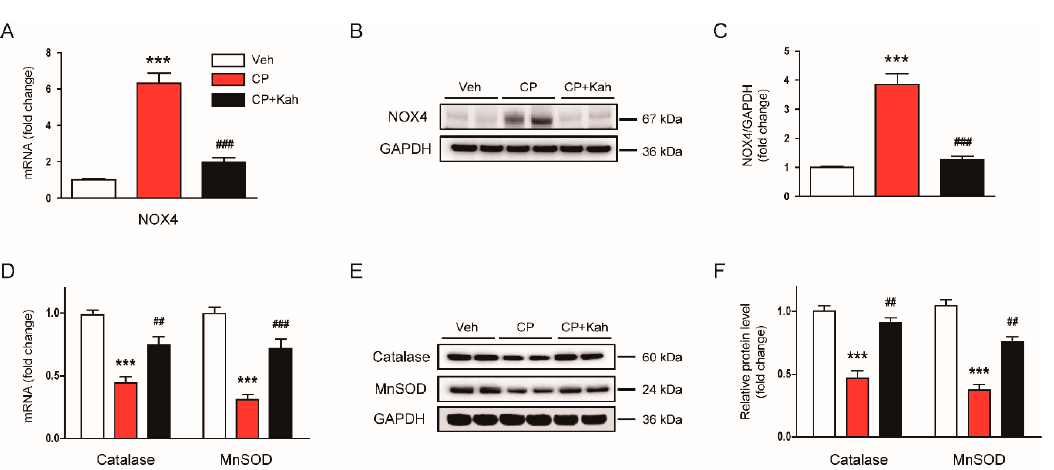
Figure 6. Effect of kahweol on oxidative stress-related enzymes in cisplatin-injected mice. ( A ) The mRNA levels of nicotinamide adenine dinucleotide phosphate oxidase 4 (NOX4). ( B ) Western blotting of NOX4. ( C ) Quantification of Western blot for NOX4. Glyceraldehyde-3-phosphate dehydrogenase (GAPDH) was used as an internal control. ( D ) The mRNA levels of catalase and manganese superoxide dismutase (MnSOD). ( E ) Western blotting of catalase and MnSOD. ( F ) Quantification of Western blots for catalase and MnSOD. GAPDH was used as an internal control. n = 8 per group. *** p < 0.001 vs. Veh. ## p < 0.001 and ### p < 0.001 vs. CP.